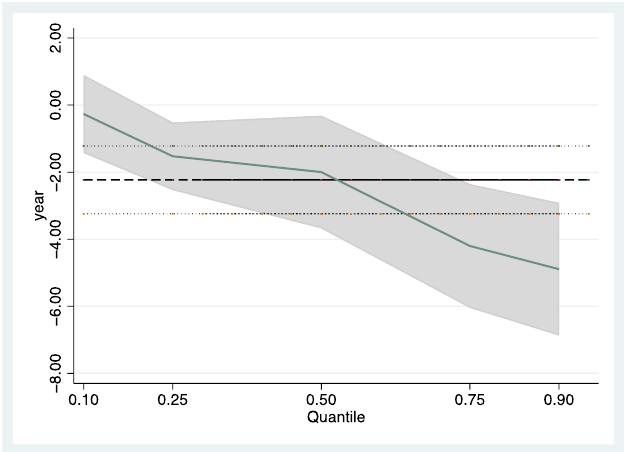
Figure 2. Change in panel quantile coefficients. Notes: x -axis represents the conditional quantile of (fragmentation), and the y -axis denotes the coefficient values of (year). To represent the variation of forest fragmentation more visually, we plotted Figure 3. As shown in Figure 3, the darker the color, the higher the value of LSI, and the more fragmented the forest landscape pattern.